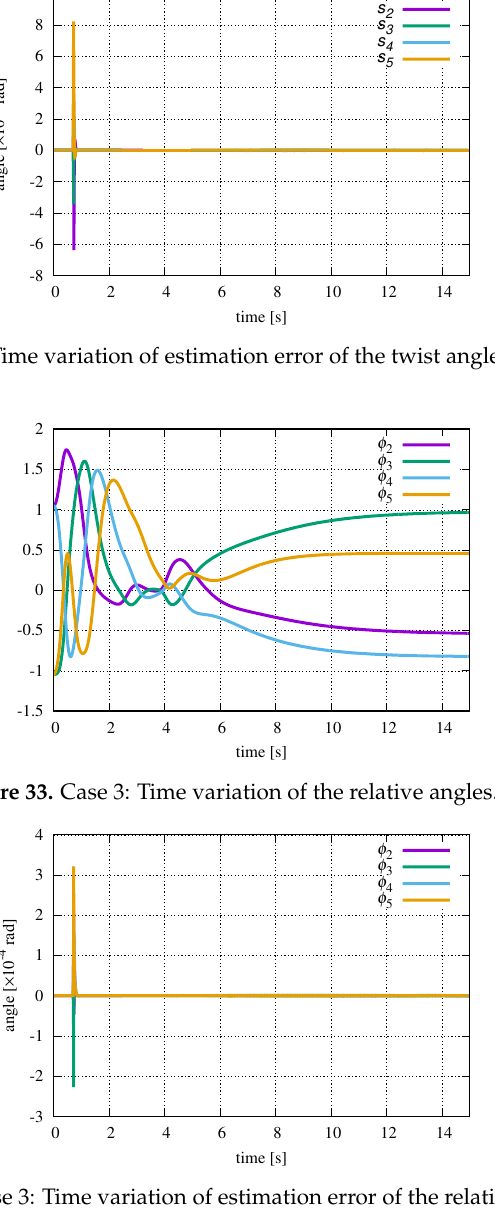
Figure 34. Case 3: Time variation of estimation error of the relative